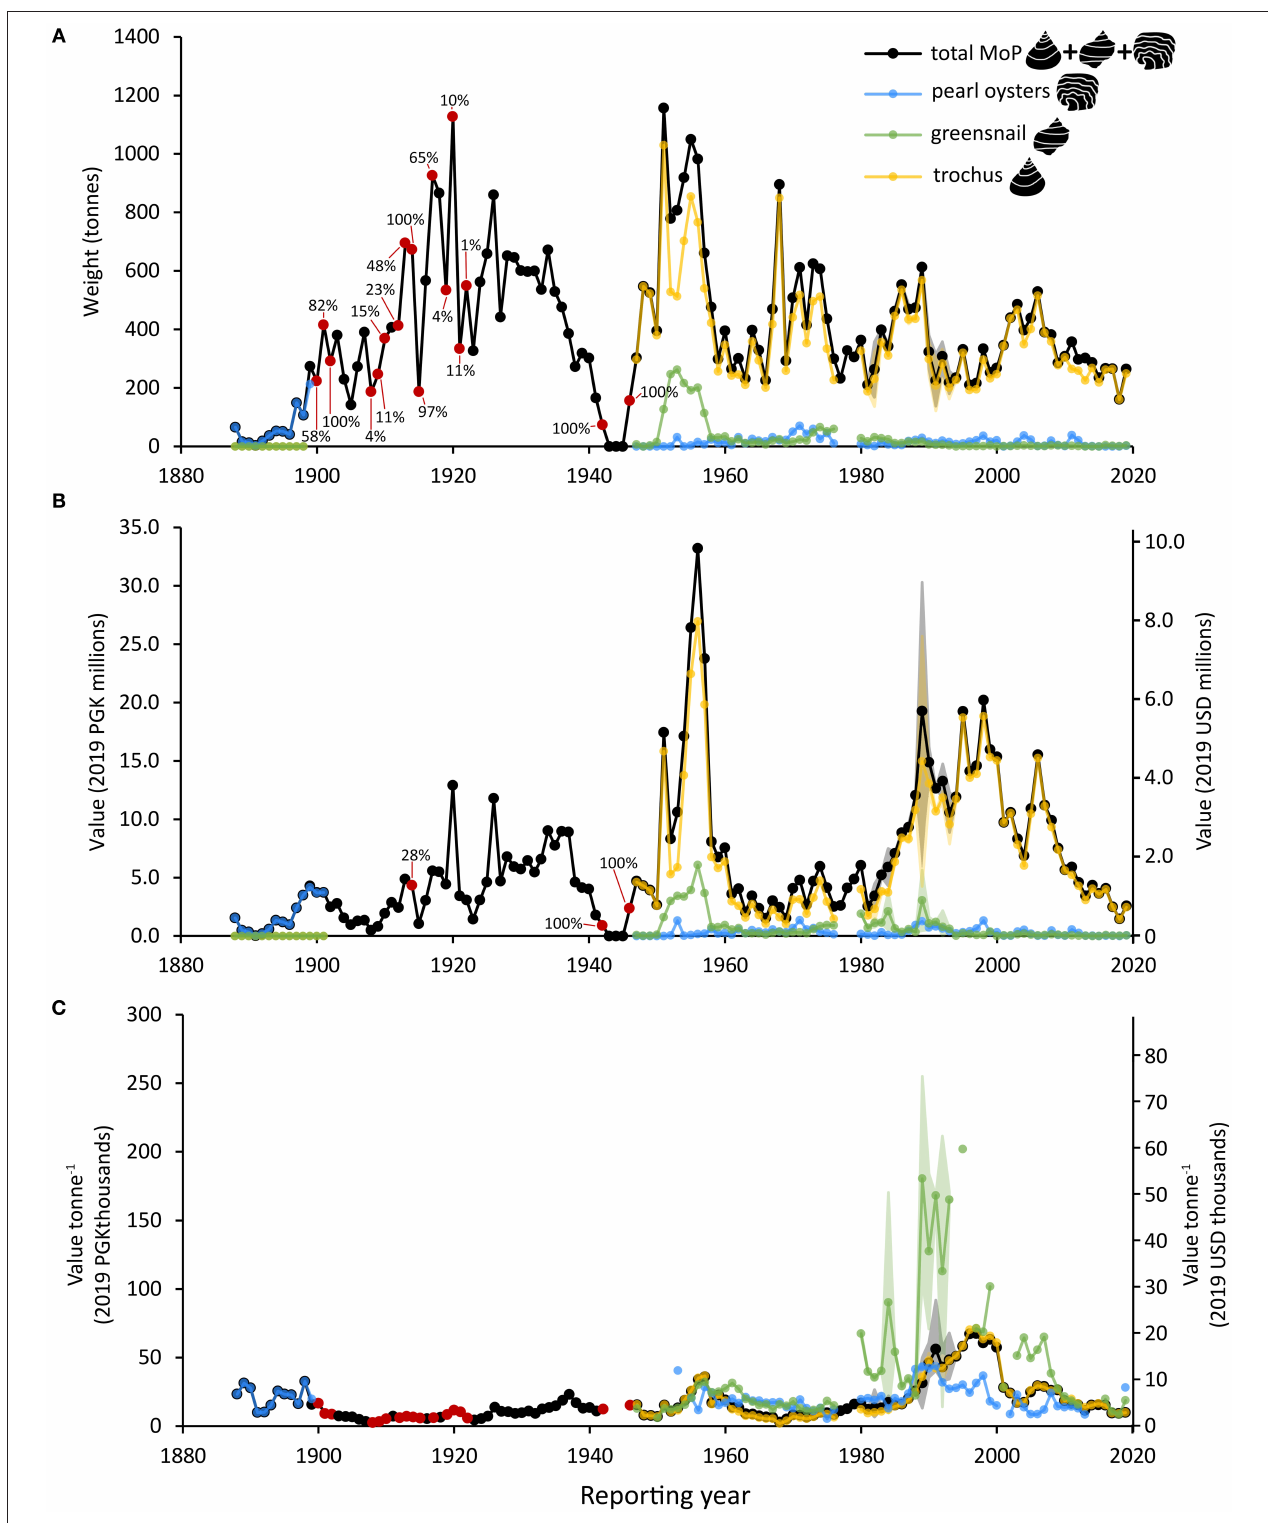
FIGURE 1 | Visualisation of the annual (A) weight, (B) value, and (C) value tonne − 1 of mother-of-pearl (MoP) exports from Papua New Guinea between 1888 and 2019. Total MoP exports are differentiated as pearl oysters ( Pinctada spp.), greensnail ( Turbo marmoratus ), and trochus ( Rochia nilotica ) for reporting years with a reasonable degree of accuracy (i.e., unspecified MoP accounted for < 10% of exports). Shading identifies the 95% confidence interval. Data partly or entirely derived through interpolation are marked in red and the relative contribution of interpolated data to the weight and value of total MoP exports indicated as a percentage. Data can be accessed as described in the Dataset